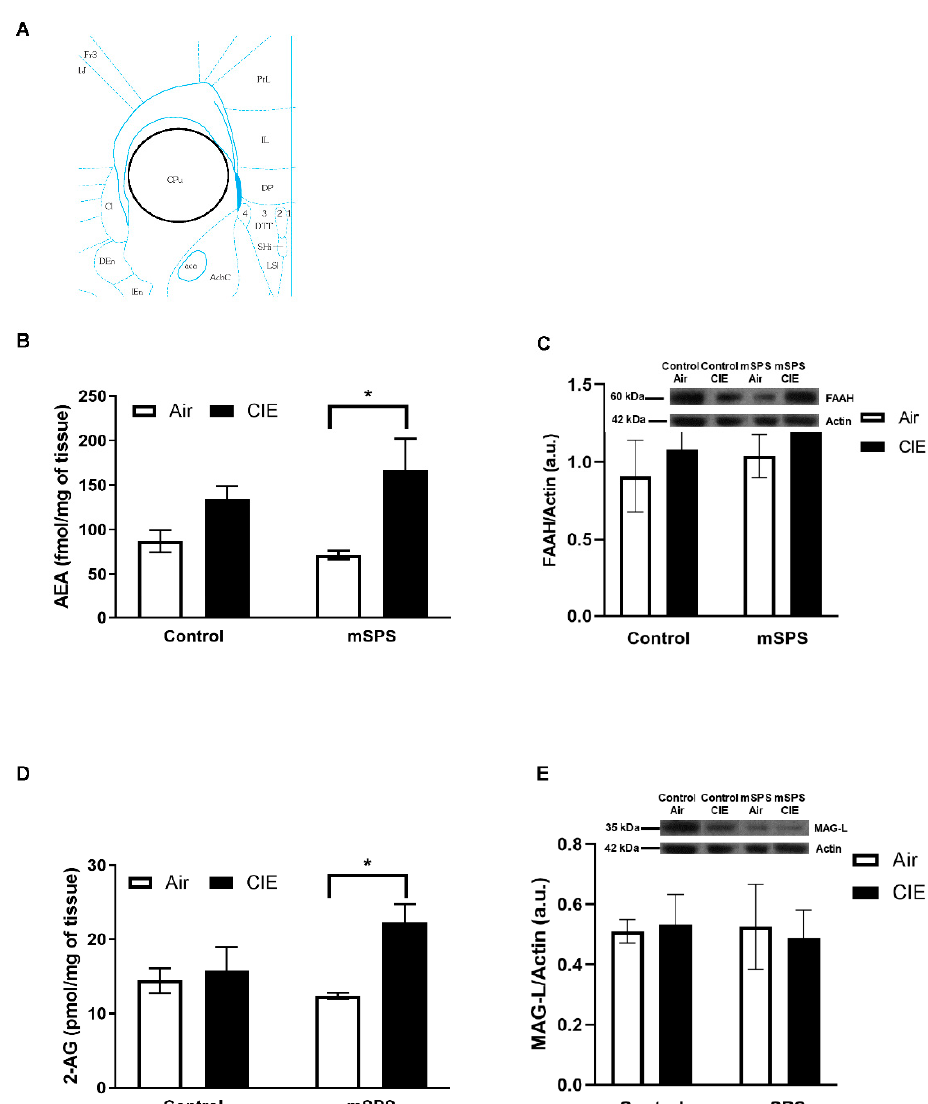
Figure 2. Anandamide (AEA) and 2-arachidonoylglycerol (2-AG) contents, fatty acid amide hy- drolase (FAAH) and monoacylglycerol lipase (MAG-L) levels in the anterior striatum (STR) after mSPS/Control or Air/CIE exposures. ( A ) Schematic of coronal slice where anterior STR tissue punches were taken bilaterally (adapted from [58]). Average ( B ) AEA content (Control-Air: n = 6; Control CIE: n = 7; mSPS-Air: n = 6; mSPS-CIE: n = 8) in the anterior STR was significantly in- creased in mSPS-CIE mice compared to mSPS-Air mice (* p < 0.05). However, average ( C ) FAAH level (Control-Air: n = 7; Control CIE: n = 4; mSPS-Air: n = 5; mSPS-CIE: n = 8) did not change among groups (Inset: representative immunoblotting sample images). Average ( D ) 2-AG content (Control-Air: n = 6; Control CIE: n = 6; mSPS-Air: n = 5; mSPS-CIE: n = 8) in the anterior STR was significantly increased in mSPS-CIE mice compared to mSPS-Air mice (* p < 0.05), but the average ( E ) MAG-L levels (Control-Air: n = 7; Control CIE: n = 4; mSPS-Air: n = 5; mSPS-CIE: n = 8) did not change among groups (Inset: representative immunoblotting sample images). Data are mean ± SEM.